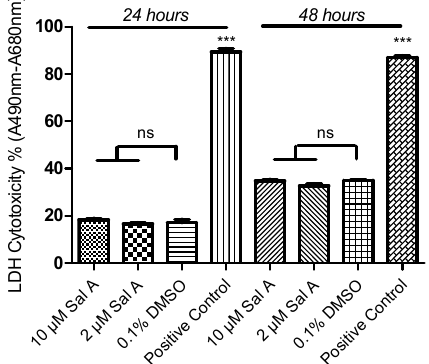
Figure 7. Determination of lactate dehydrogenase (LDH) cytotoxicity of Sal A in HUVEC cells. HUVEC cells were plated in a 96-well plate in maintaining medium. Different concentrations of Sal A were added to the culture media and incubated for 24 and 48 h at 37 °C, 5% CO 2 . Meanwhile, 1X Lysis Buffer was used as positive control. LDH cytotoxicity was measured using the Pierce LDH Cytotoxicity Assay Kit (Thermo Scientific). Data were expressed as mean ± SD, n = 3. Statistical analysis of original optical density value measurement was conducted using a one-way ANOVA and a with Tukey test. *** p < 0.001. ns : no significant difference.